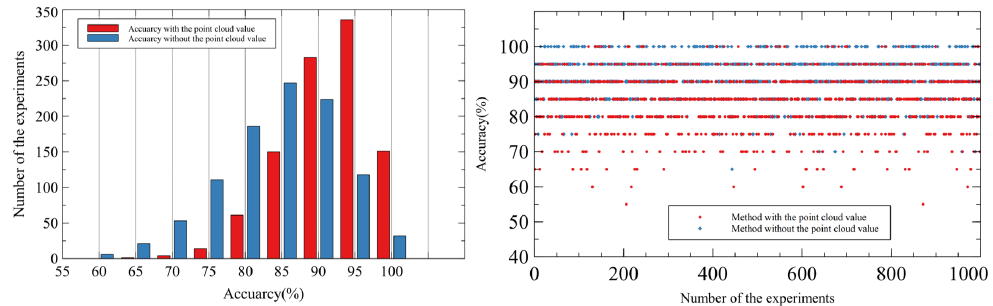
Figure 19. Classification result.